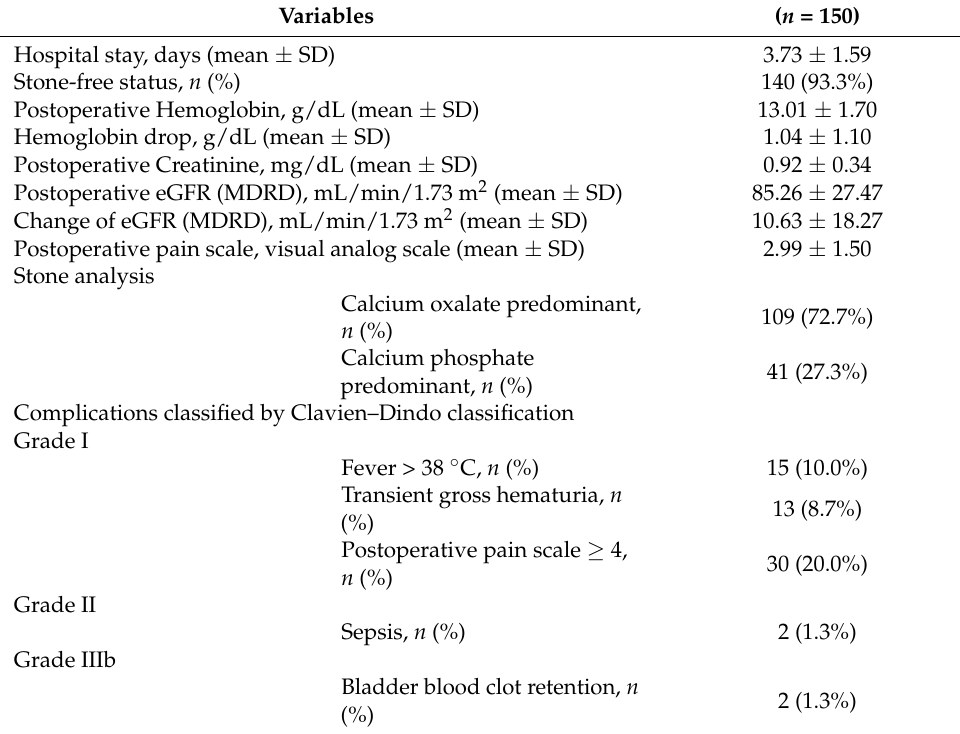
Table 3. Postoperative